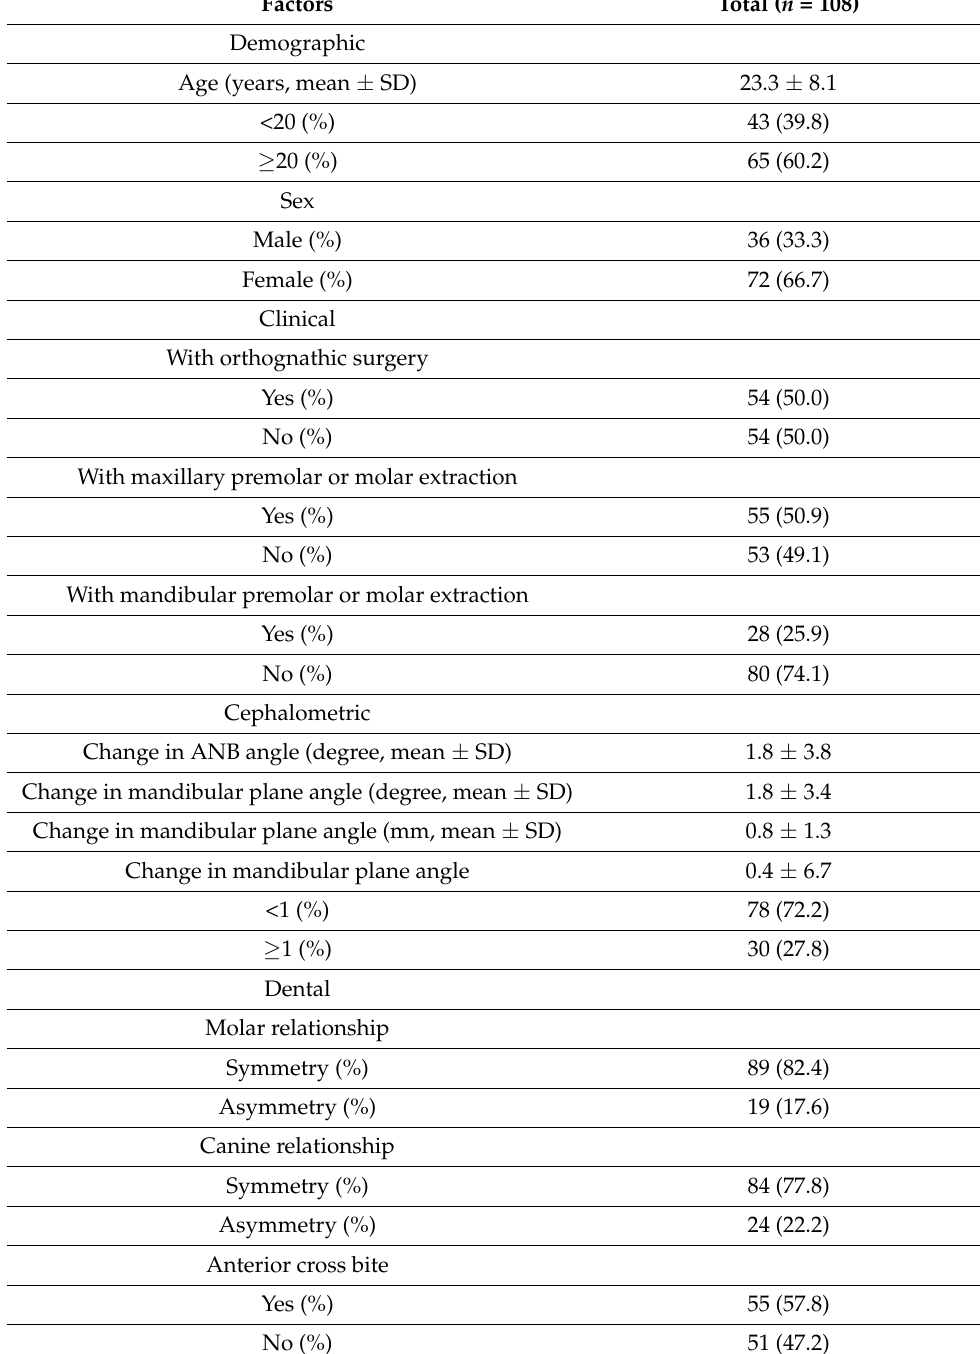
Table 1. Patient